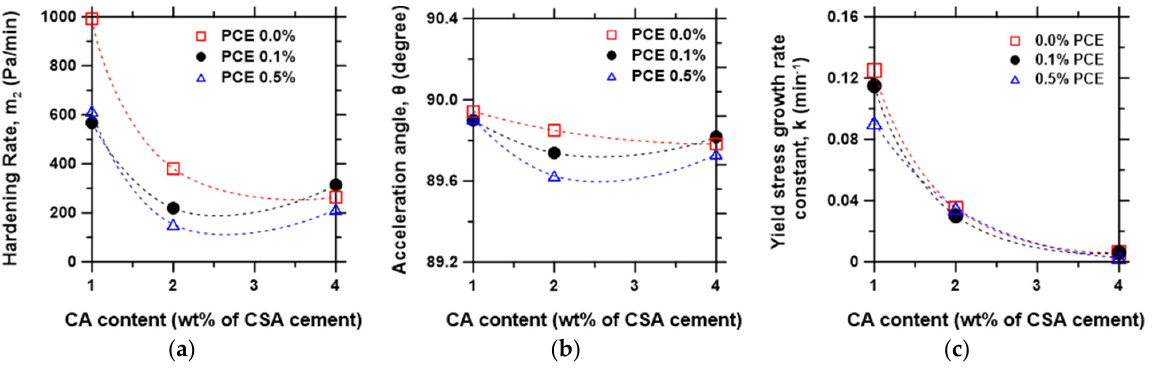
Figure 6. The hardening rate, 𝒎 𝟐 , of the CSA cement pastes: ( a ) the evolution of 𝒎 𝟐 as a function of admixture dosage, ( b ) the evolution of acceleration angle, 𝜽 𝒑 , and ( c ) Yield stress growth rate constant 𝒌